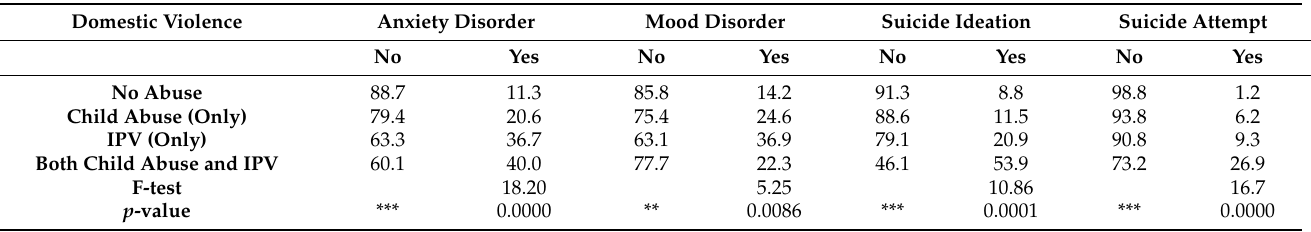
Table 2. Bivariate Analysis of Domestic Violence and Mental Disorders and Behaviors Among Caribbean Black